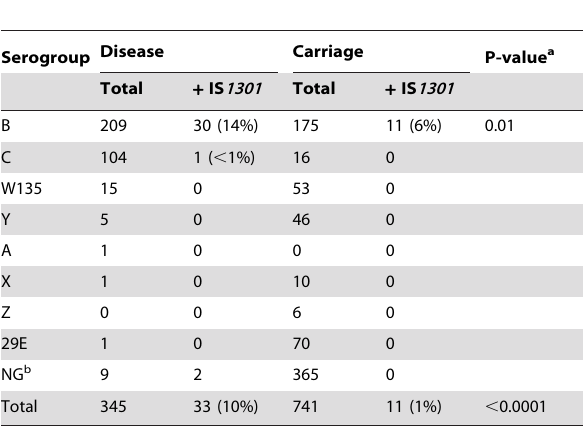
Table 1. Presence of IS 1301 in the IGR of UK disease and carriage isolates from South East England.